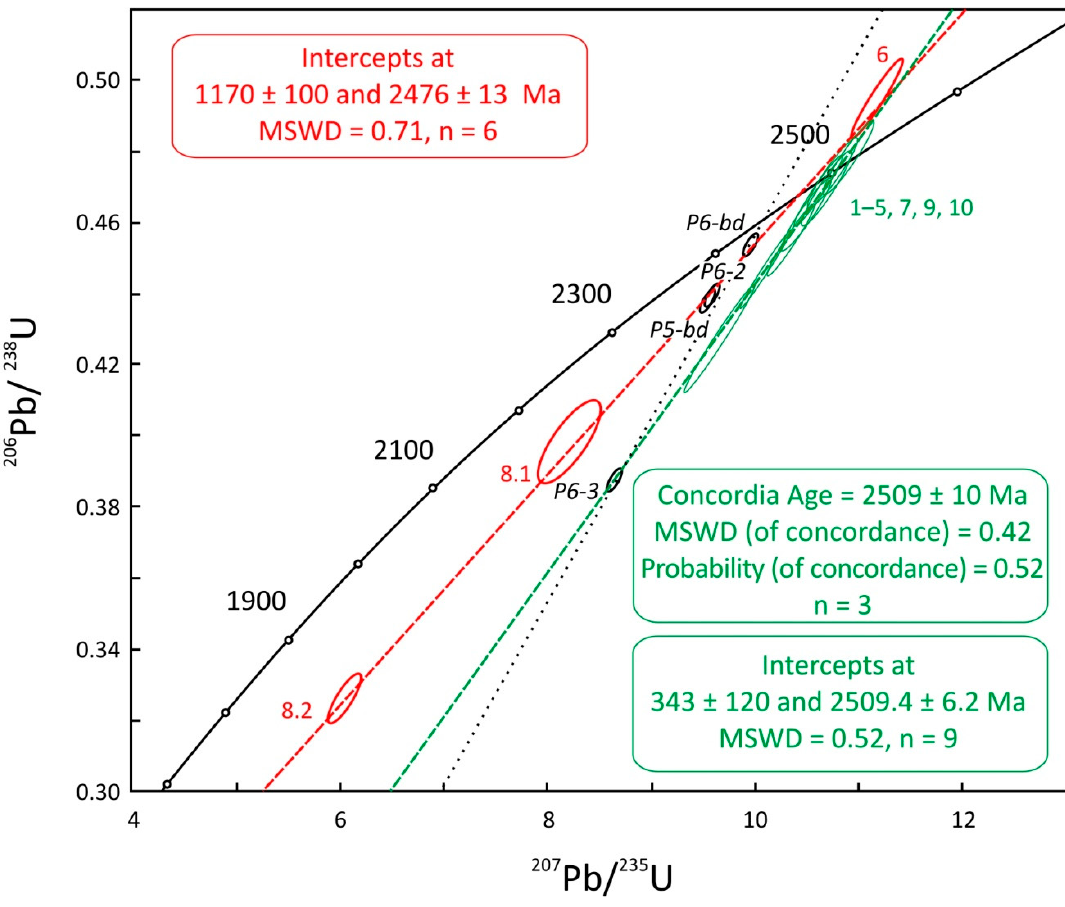
Figure 7. Concordia diagram for zircons separated from sample BG29 (coarse-grained anorthosite) with zircon and baddeleyite data from samples P5 and P6 (italic). Green ellipses show zircon with high Th/U ratios (mainly 0.9–3.7); red ellipses represent zircon with low Th/U ratios (0.1–0.9); black ellipses show zircon and baddeleyite (bd) from [13]. The dotted line shows the discordia exclusively based on ID-TIMS